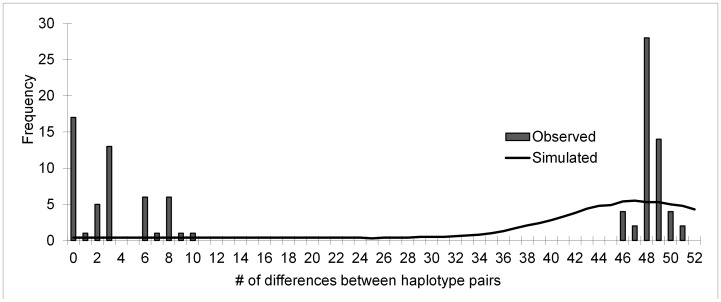
Mismatch of ND4 haplotypes within population of Java.Characteristic bimodal distribution of haplotype relationships within admixed populations.